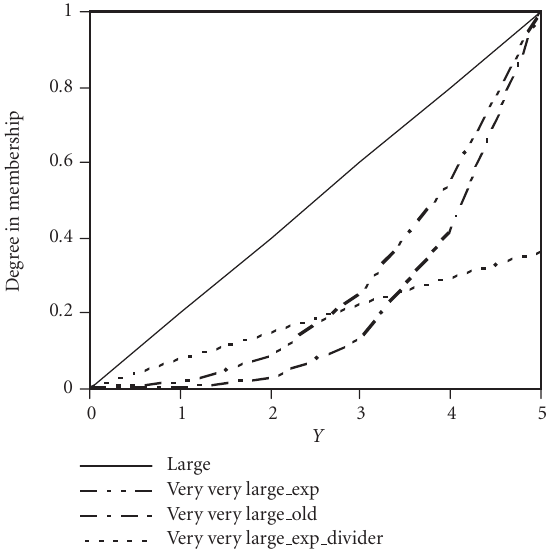
Figure 3.5. Schematic illustration of linguistic hedge “very very” using